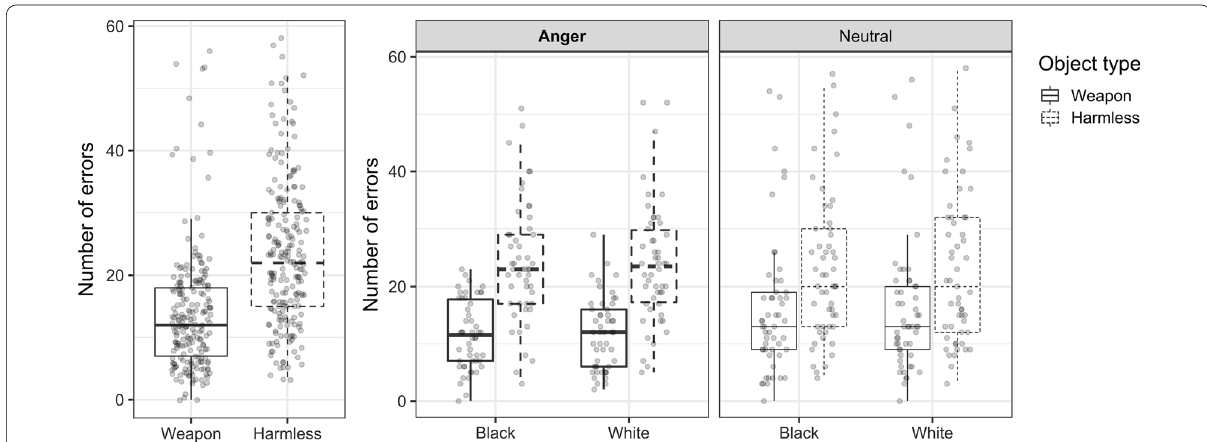
Fig. 2 Boxplots detailing the number of errors as a function of object type, both averaged across emotion condition and race prime (left) and plotted separately by emotion condition and race prime